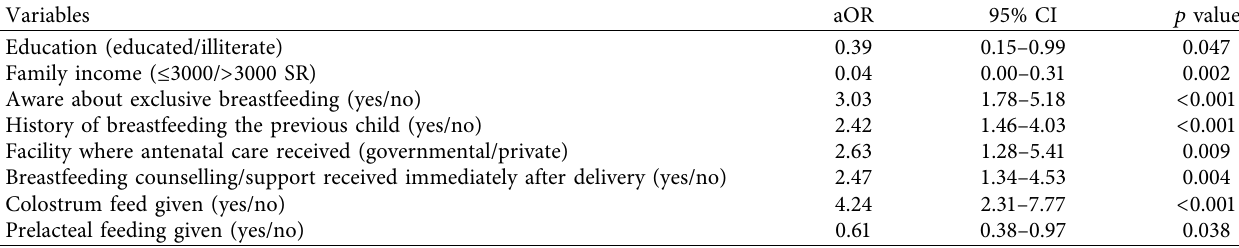
Table 3: Multivariate logistic regression model for independent predictors of practice exclusive breastfeeding among mothers in Hail city, Saudi Arabia,